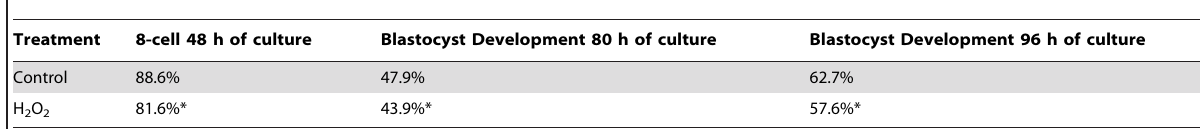
Table 1. Development of embryos derived from sperm treated with 1500 m M H 2 O 2 .